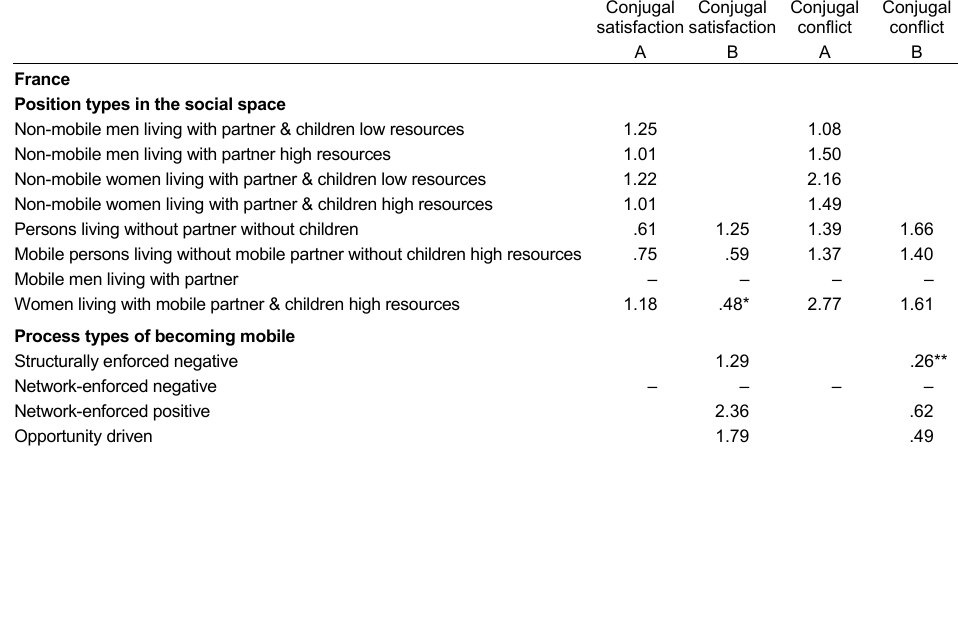
Table 4 : Logistic regressions of conjugal satisfaction and conjugal conflict on position and process types ( Odds Ratios